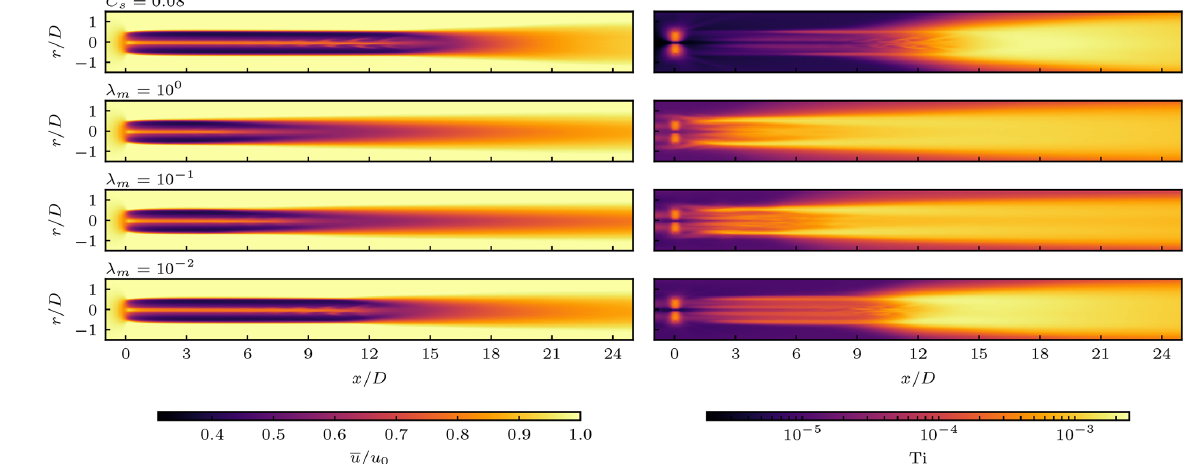
Figure 18. Contour plots of the mean stream-wise velocity u (left panels) and turbulence intensity Ti (right panels) in the central stream-wise plane in uniform inflow. Top panels: Smagorinsky model with a practically switched-off limiter, i.e. λ m = 10 − 6 (as described in Sect. 4). Second to last row panels: no explicit turbulence model with different values of the third-order cumulant